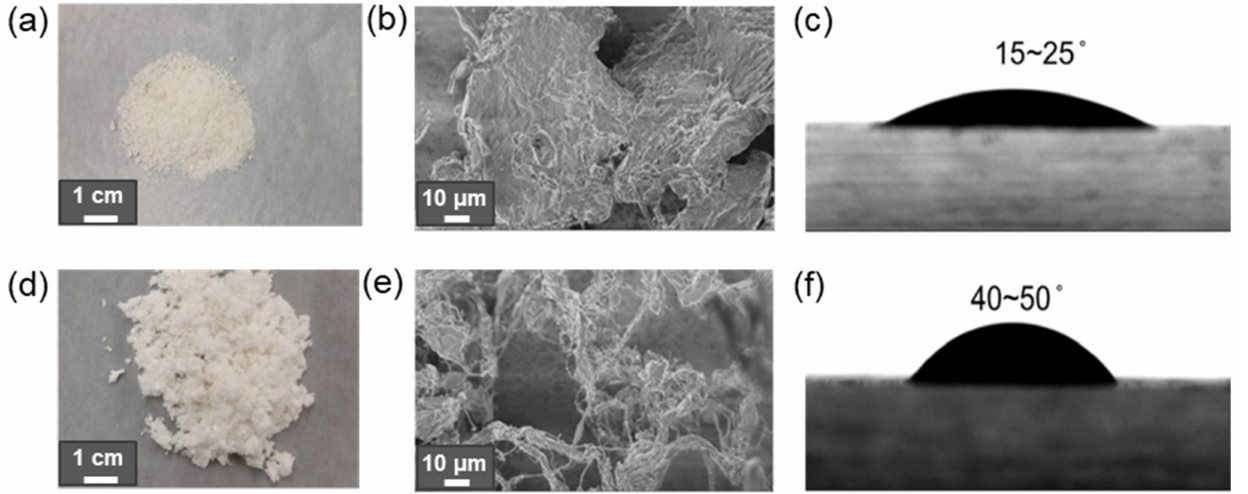
Figure 6. Images of the neat CMF ( a ) and lauryl-CMF ( d ), SEM images of the neat CMF ( b ) and lauryl-CMF ( e ) and contact angles of the neat CMF ( c ) and lauryl-CMF ( f ). Reproduced from [148] with permission of